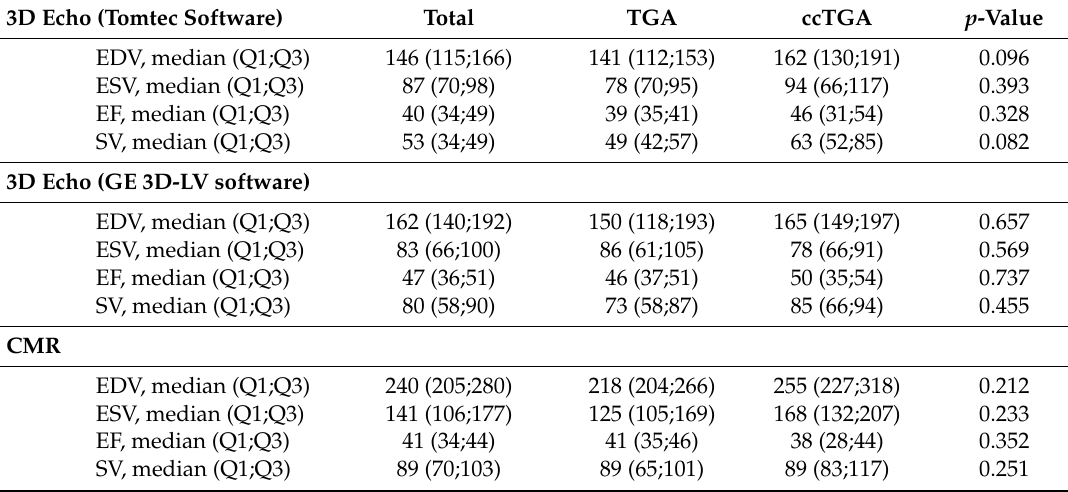
Table 3. Systemic right ventricular volumes determined by two di ff erent 3D echocardiography software solutions (tomtec and GE), as well as volumes as measured by cardiac magnetic resonance imaging. EDV = end-diastolic volume, ESV = end-systolic volume, EF = ejection fraction, SV = stroke volume, CMR = cardiac magnetic resonance imaging, TGA = transposition of the great arteries, ccTGA = congenitally corrected transposition of the great